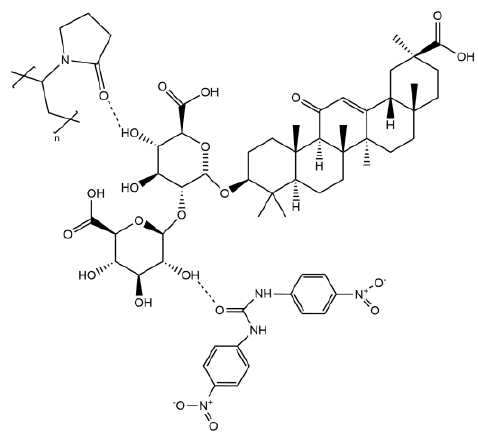
Figure 12. Concentration of DNC in plasma after oral administration.